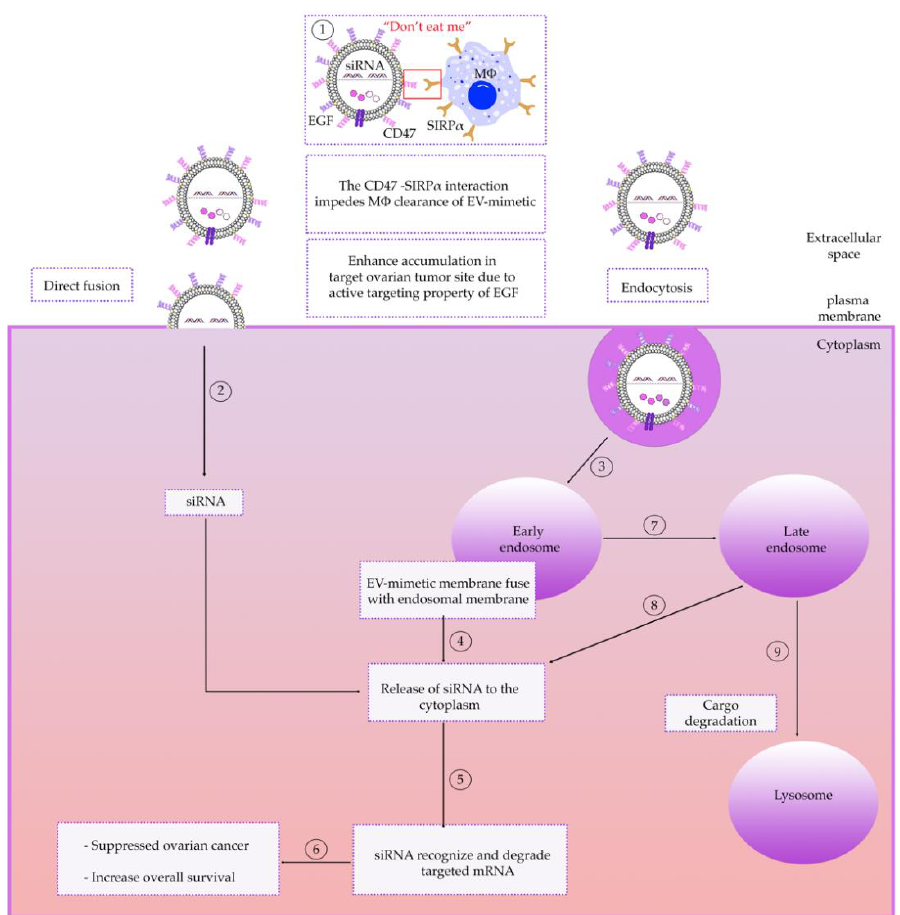
Figure 3. Schematic of the intracellular delivery of EV-mimetic with RNAi cargo to OC. Increased targeting of therapeutic EV-mimetic to OC cells and extension of their half-life of EV-mimetic in extracellular space can be achieved by coating EV-mimetics with molecules that enable specific targeting of tumor cells (such as EGF) or with molecules that enable escape of phagocytosis by macrophages (synthetic peptide CD47). Interaction of CD47 with SIRPα receptor on macrophages (MΦ) impedes the clearance of EV-mimetics and enhances accumulation in target tissue (1). After encountering the target cell, the EV-mimetic is typically bound to its surface via cell-surface receptors, integrins, etc. After establishing an interaction with the cell surface, EV-mimetics can be taken up by the OC cell via two mechanisms of internalization: firstly, involving direct fusion with the plasma membrane (2) or secondly via endocytosis; whereby EV-mimetics are taken up by early endosome (3). siRNA cargo is released into the cytoplasm (4). siRNA recognize and degrade targeted messen- ger RNAs (mRNAs) (5). This in turn leads to the suppression of OC and increases overall survival (6). Early endosomes will gradually transform into late endosomes (7) and possible release of siRNA to the cytoplasm (8). Further down the endocytic pathway, endosomes fuse with lysosomes, conse- quently cargo that has not been released to the cytoplasm will be degraded (9). Adapted from O’Brien et al. [229]. Un and colleagues [222] demonstrated that liposomal components might be trans- ported via different intracellular trafficking process after clathrin-mediated endocytosis. The intracellular localization of DOPC derived from liposomes was to the endoplasmic reticulum (ER) and Golgi apparatus, which was partly controlled by oxysterol-binding protein-related protein 1 (ORP1). Whereas the intracellular localization of Chol derived from liposomes was to the ER, which was partly controlled by Niemann–Pick C1 protein (NPC1). The results indicate that phosphatidylcholine-based liposomes are degraded